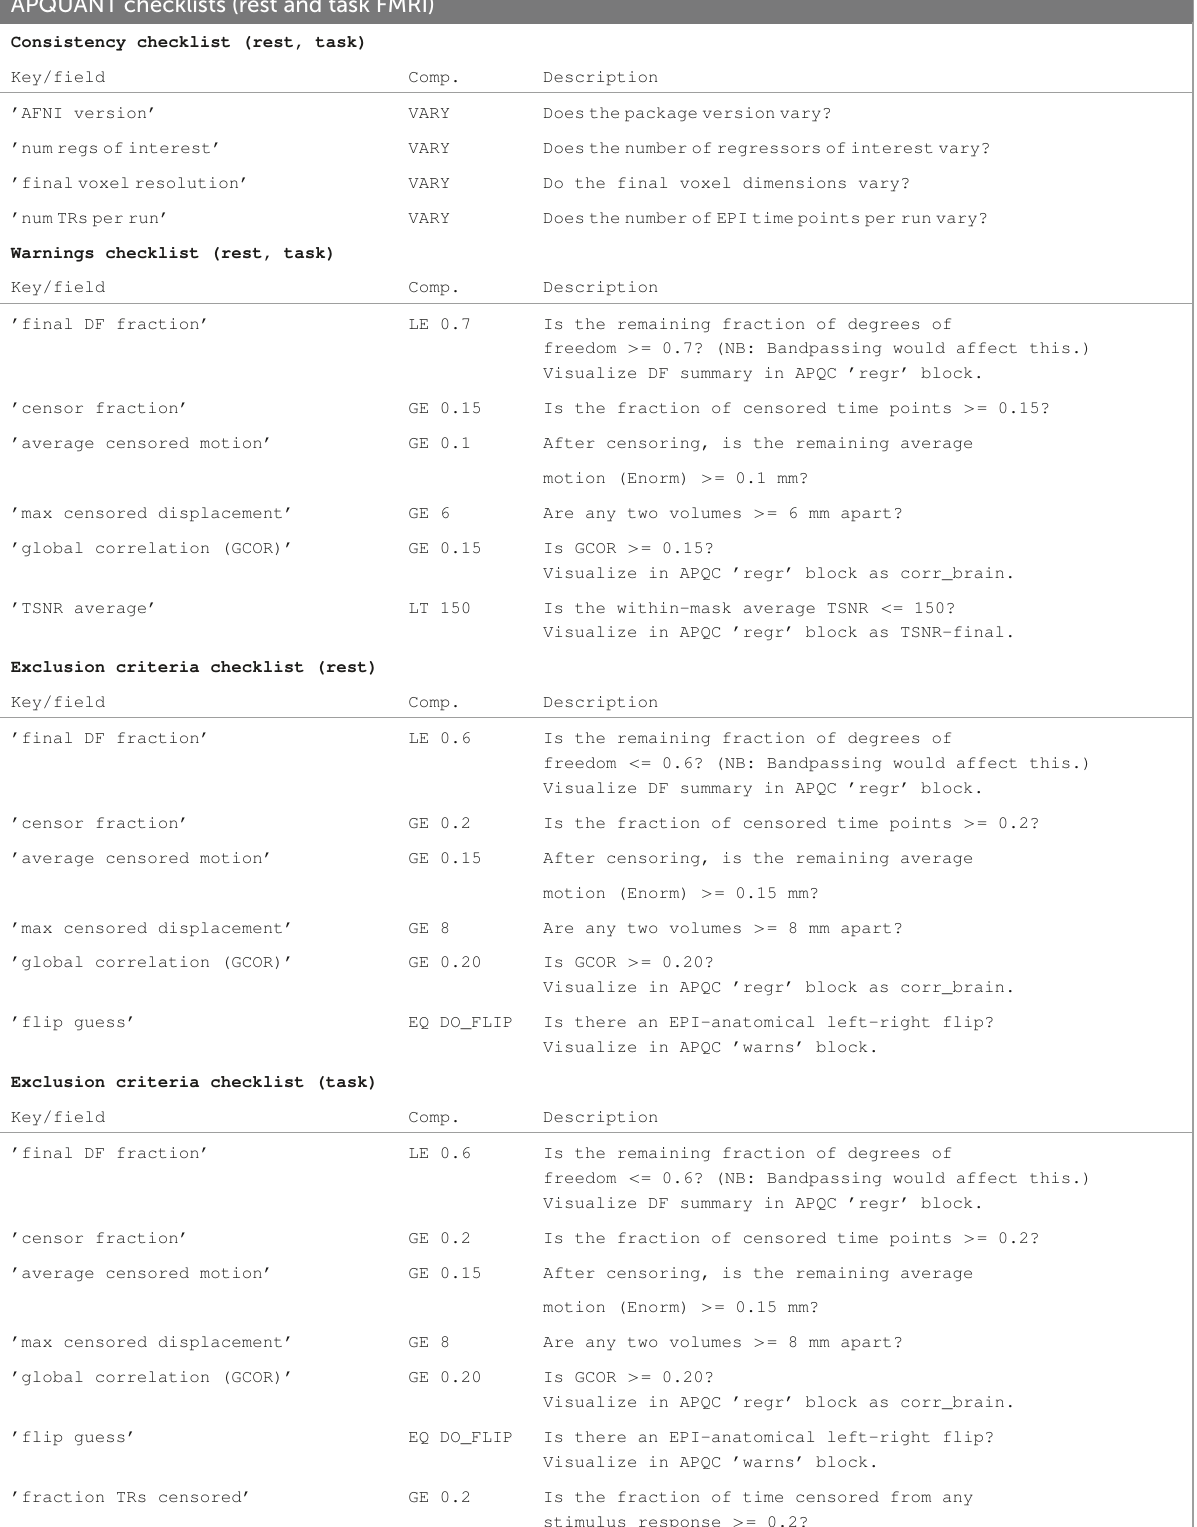
TABLE 1 Lists of QC criteria for generating review tables of different properties after completing single subject processing with afni_proc.py. APQUANT checklists (rest and task